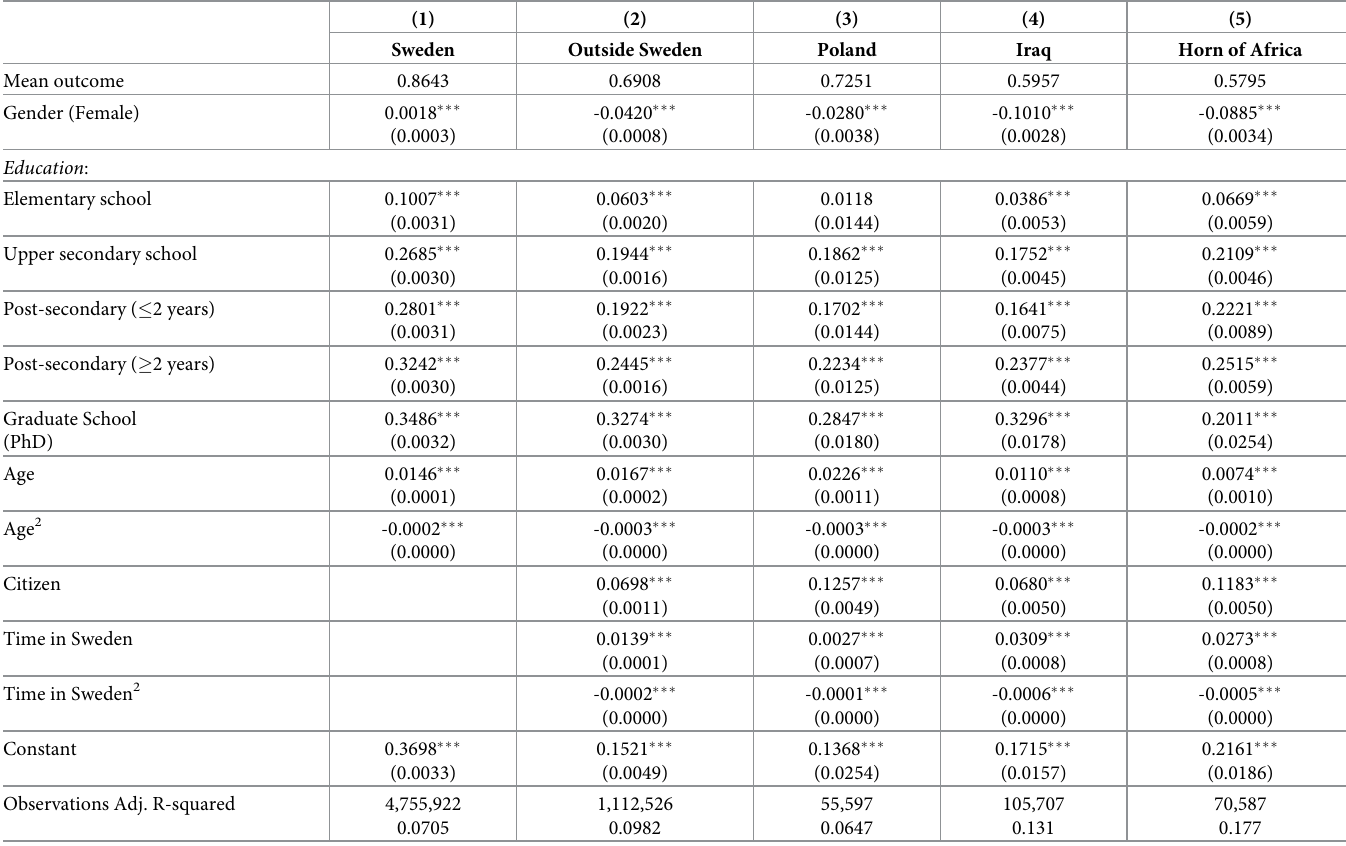
Table 1. Correlates of having employment by country of